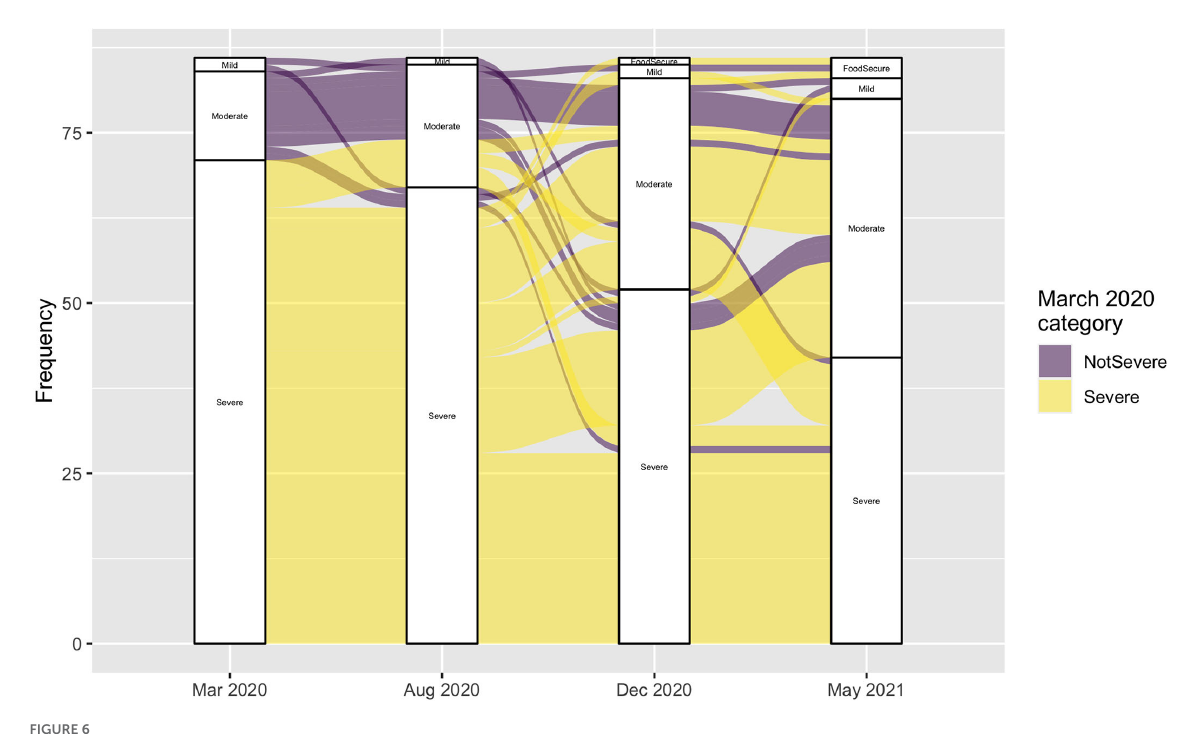
FIGURE6 Transitions between food security categories across